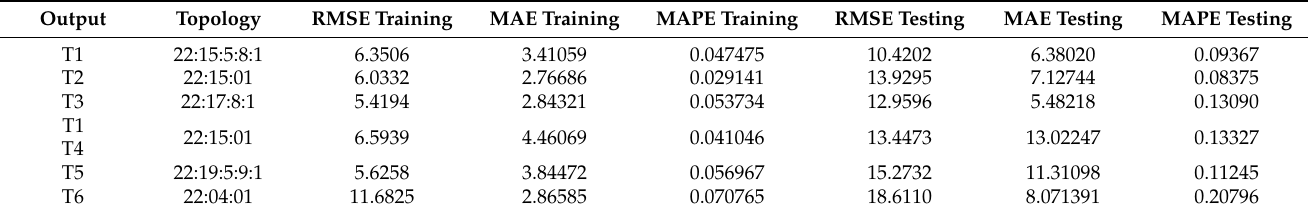
Table 2. The best ANN obtained for a single output